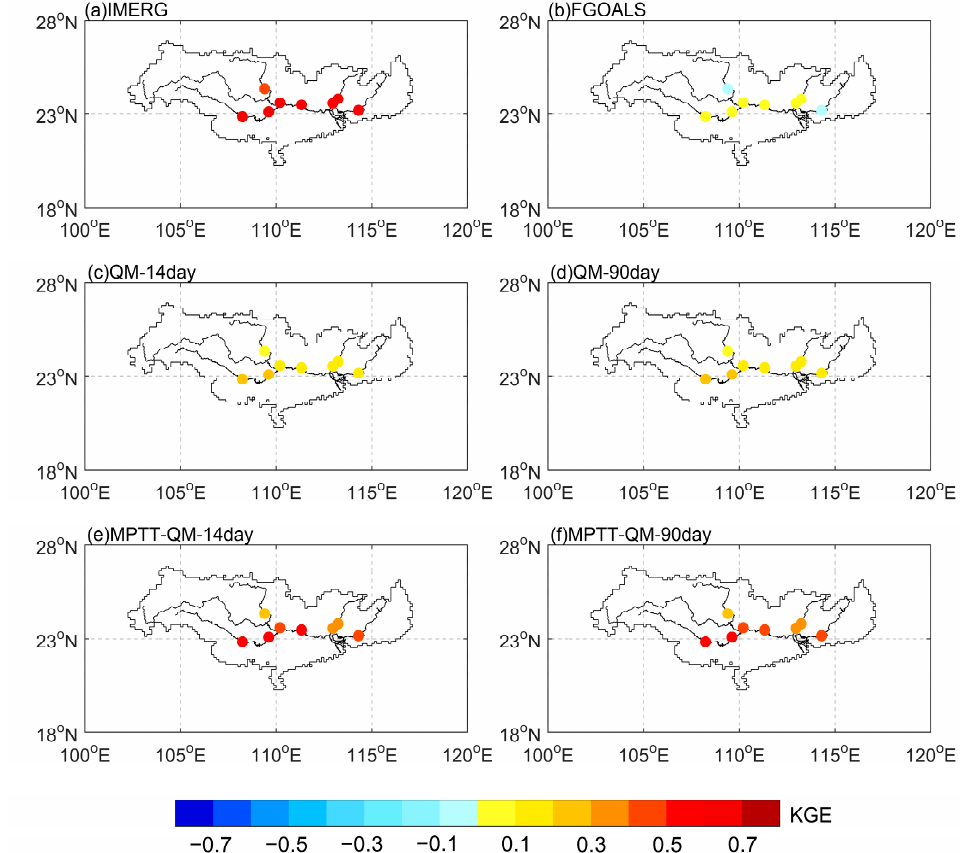
Figure 7. Spatial distribution of the monthly KGE coefficients of hydrological stations in the PRB: ( a – f ) represent the IMERG, FGOALS, QM-14day, QM-90day, MPTT-QM-14day, and MPTT-QM- 90day, respectively.